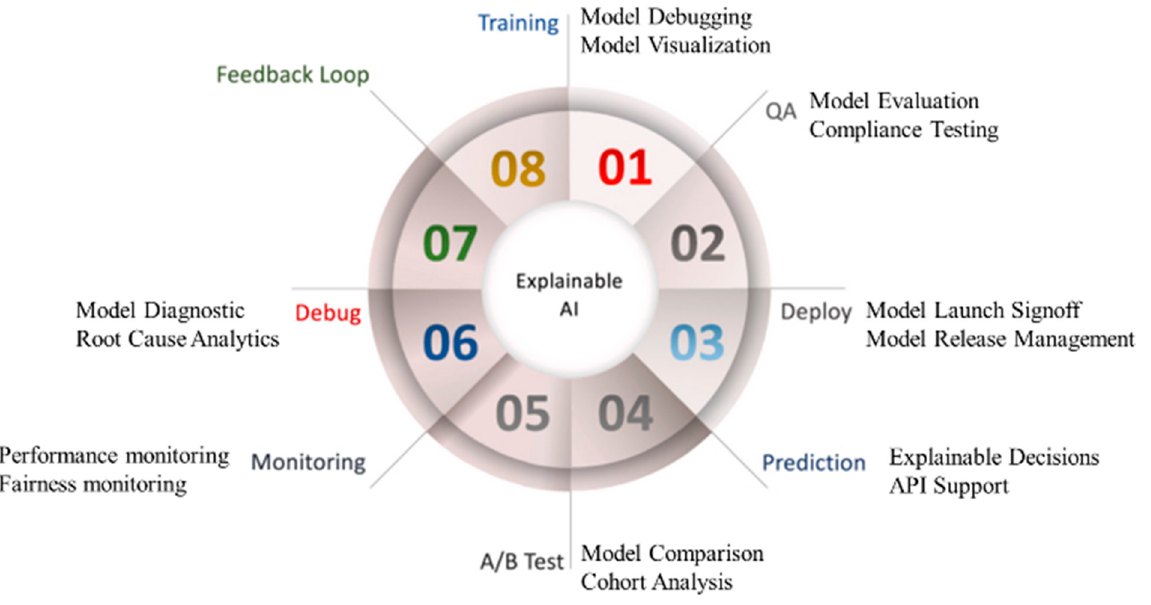
Figure 18. Eight aspects of Explainable AI